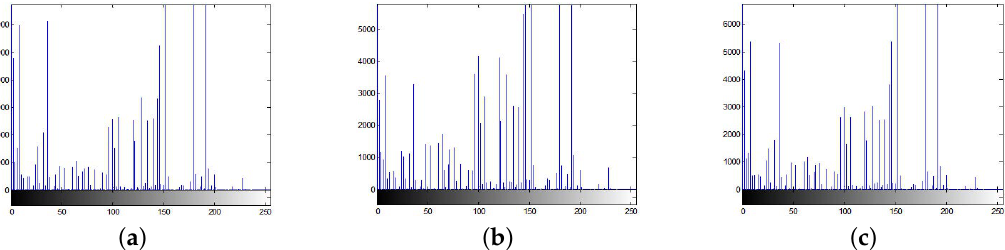
Figure 5. The histogram features of LTM: ( a – c ) corresponds to the LTM histogram of Figure 4d–f,